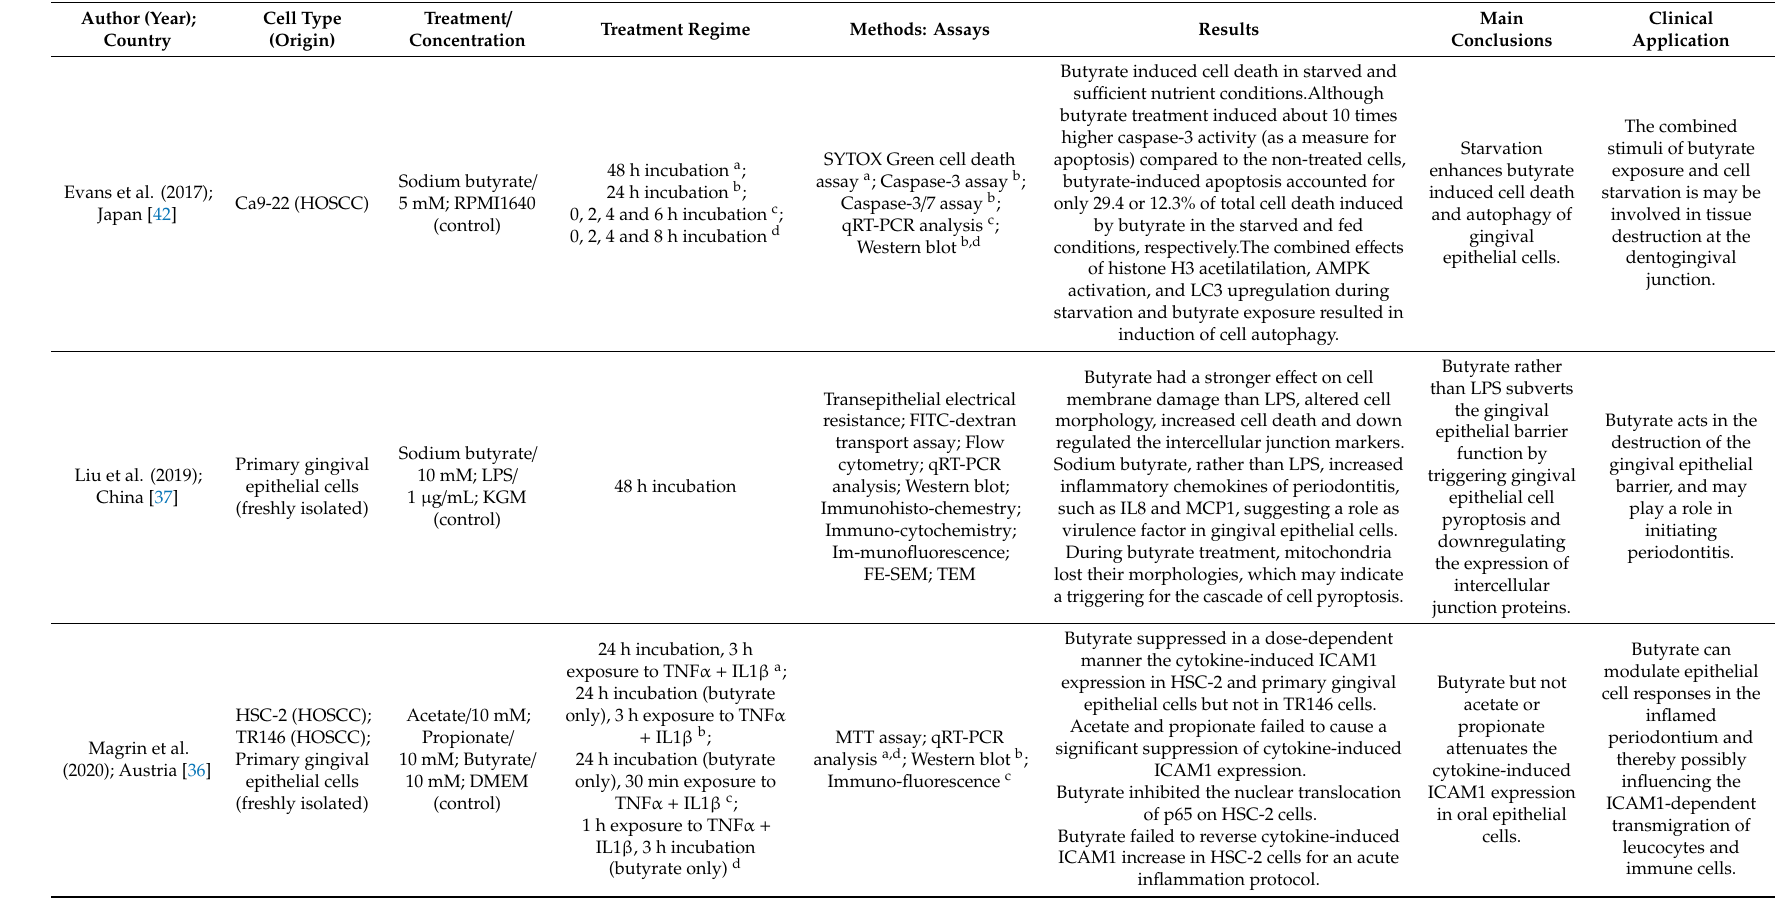
Table 1. Summary of descriptive characteristics of included articles ( n =